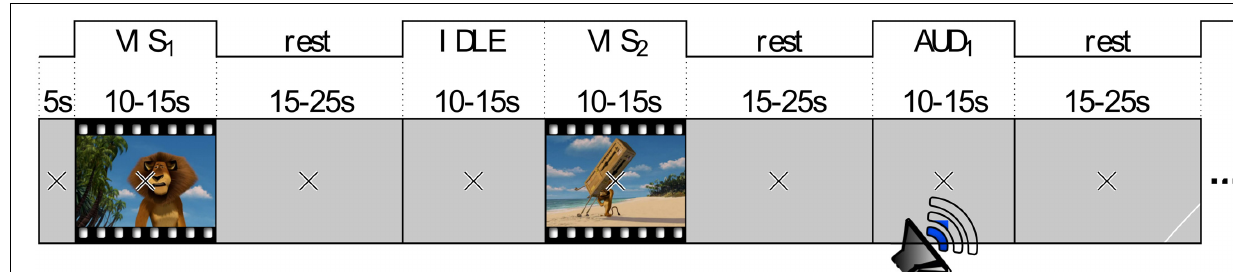
FIGURE 2 | Example of four consecutive trials with all perceptual modalities.